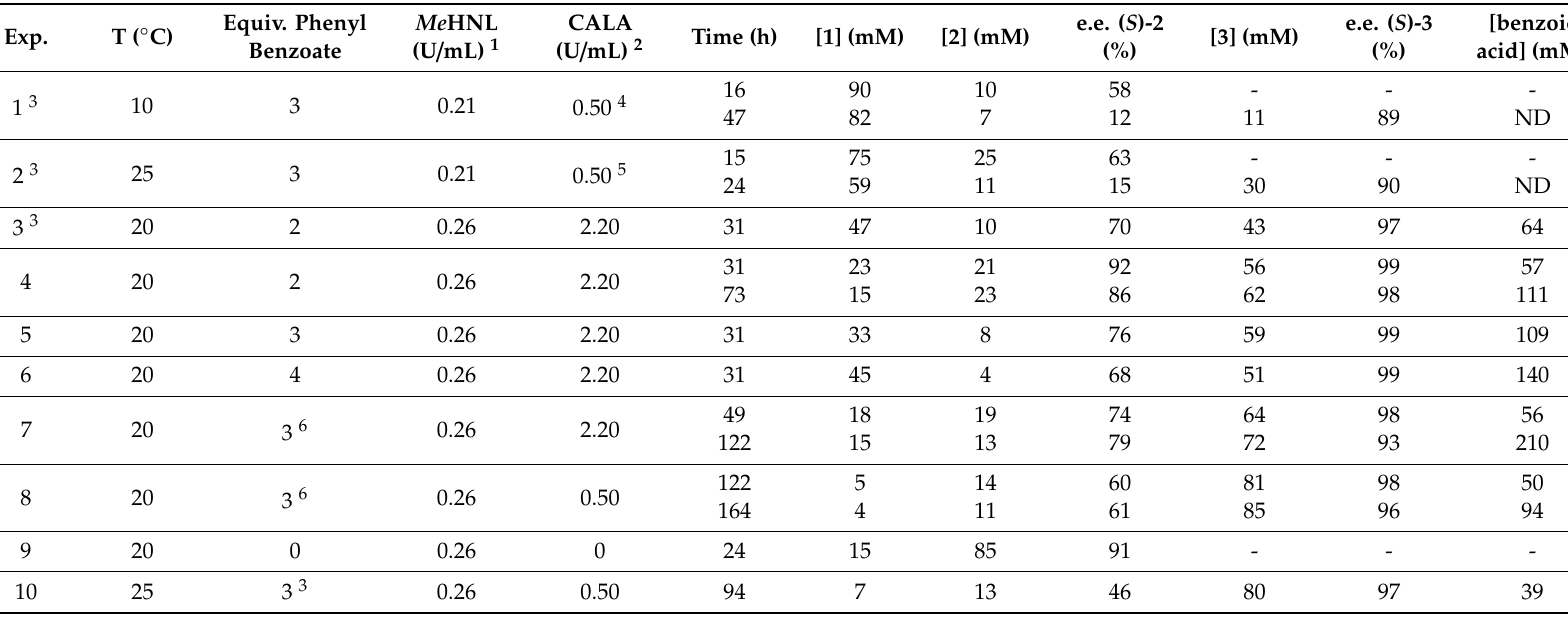
Table 1. Cascade synthesis of ( S )-4-methoxymandelonitrile benzoate catalyzed by immobilized Me HNL and CALA starting from 100 mM 4-anisaldehyde and 650 mM HCN using 200–400 mM phenyl benzoate. Reactions were performed in duplicate and relative standard deviations were generally below 2%.